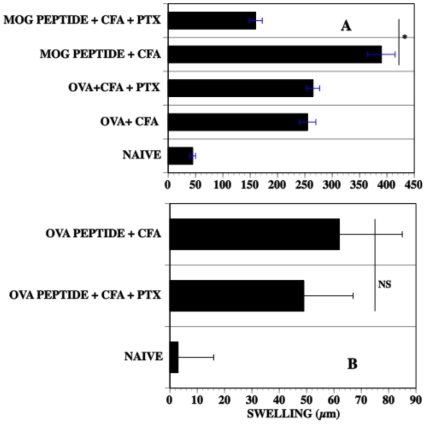
PTX reduces DTH to MOG35–55
 peptide but not to OVA.
(A) C57BL/6 mice were immunized with MOG 35–55 peptide or OVA, CFA +/− PTX. Seven days P.I. footpads of the mice were challenged with intradermal MOG peptide35–55 or OVA respectively. Swelling was measured 24 and 48 hr later. Data represents the mean swelling (µm) +/−S.E.M. of five mice/group. The experiment was done twice. (B) C57BL10.RIII mice were immunized with OVA265–280 peptide, CFA +/− pertussis toxin. Seven days P.I, footpads were challenged with 50 µg OVA35–55 peptide and swelling measured 24 hr post-challenge.Data represents the mean +/−S.E.M. of 4 mice. NS: not significant.